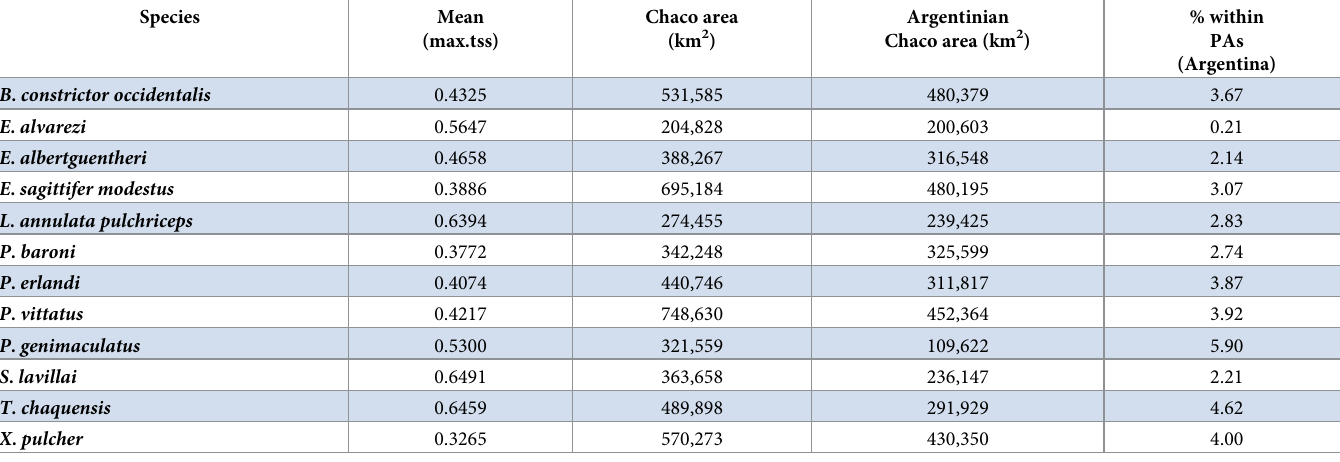
Table 3. Potential distribution area (km 2 ) of snake species in the Dry Chaco forest.